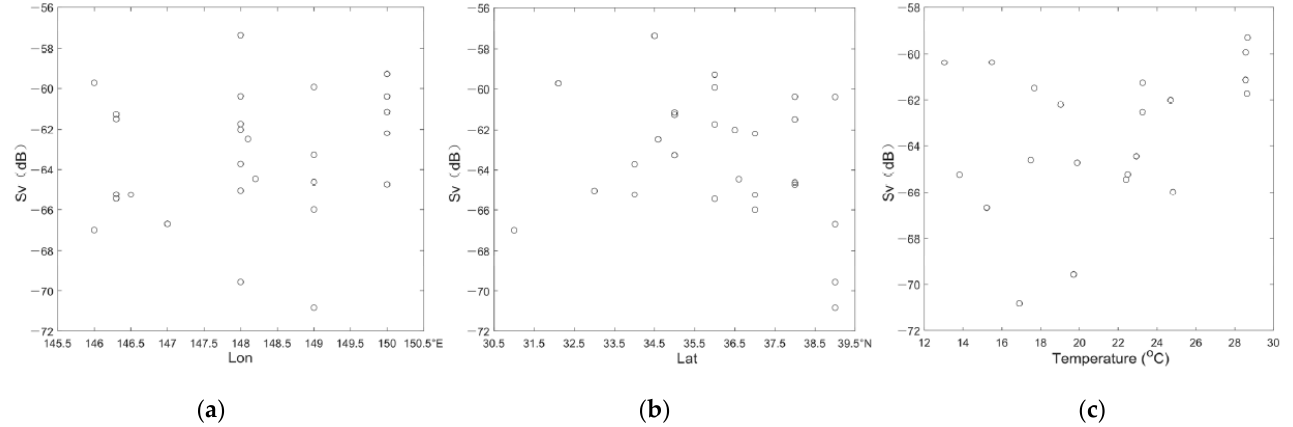
Figure 6. The Pearson correlation and linear regression analysis on the horizontal level indicate the scattering strength: ( a ) not significantly correlated with longitude (R = −0.012, p = 0.948, p > 0.05), ( b ) not significantly correlated with latitude (R = −0.239, p = 0.230, p > 0.05), ( c ) not significantly correlated with water temperature (R = 0.353, p = 0.116, p > 0.05). On the vertical level, the Pearson correlation analysis and linear regression results (without Stations 24, 30, and 31) show that 𝑆 𝑉 was negatively correlated with depth (R = −0.933, p = 0.0002, p < 0.01) and positively correlated with water temperature (R = 0.939, p = 0.0002, p < 0.01) (Figure 7).